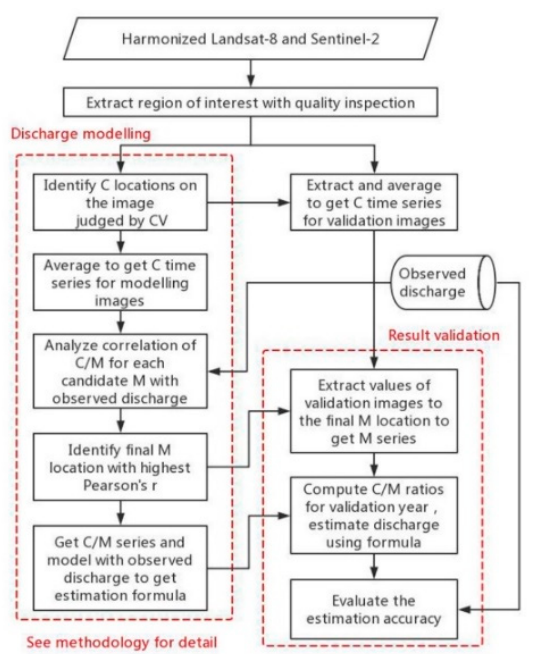
Figure 3. Flowchart of methodology (C stands for Calibration pixel, M stands for Measurement pixel, and CV stands for Coefficient of Variation).